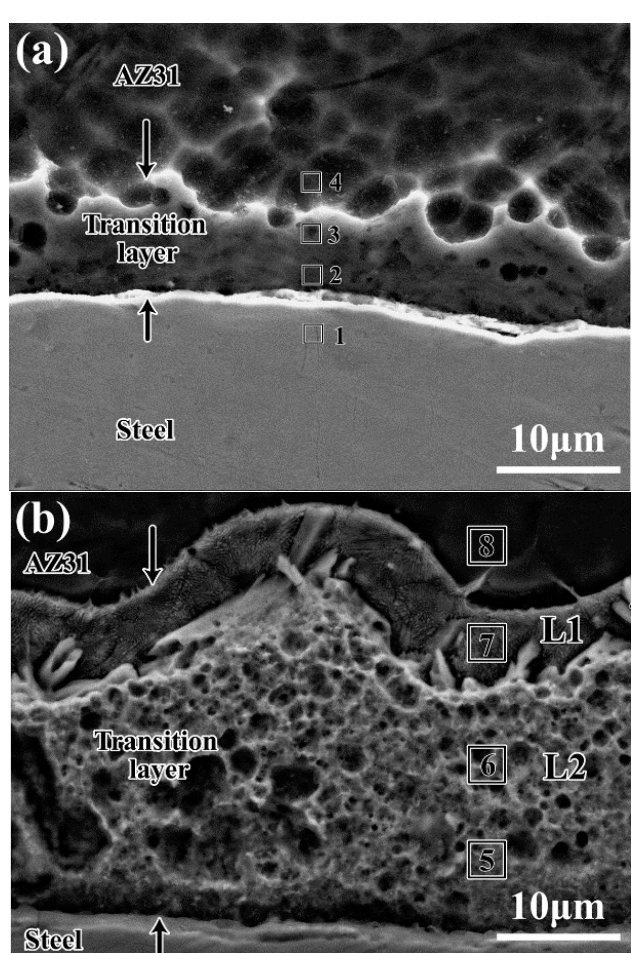
Figure 3. Microstructures of the bonding interfaces depicting the ( a ) 2 μ m-thick zinc coating, and ( b ) 20 μ m-thick zinc coating (Numbers 1–8 are the test positions of Table 2). EDX was used to analyze the composition of different regions across the transition layers in Figure 3. As shown in Table 2, Zn contents in both transition layers were higher than in the AZ31 Mg alloy, which indicated that Zn from the GS can penetrate the